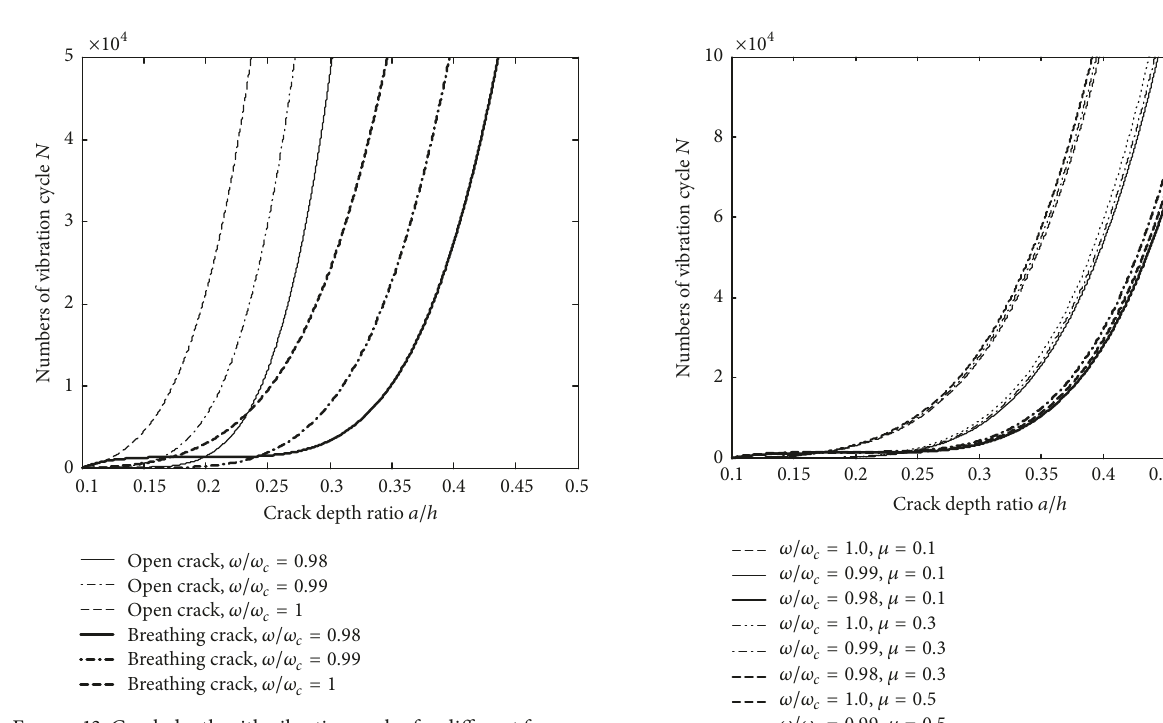
transition state between the fully open state and the fully closed state. It meets the object facts and the physical natural of crack. It may be closer to the real motion of the breathing crack than that of the square wave function. Using a breathing crack model is more realistic than using an opening crack